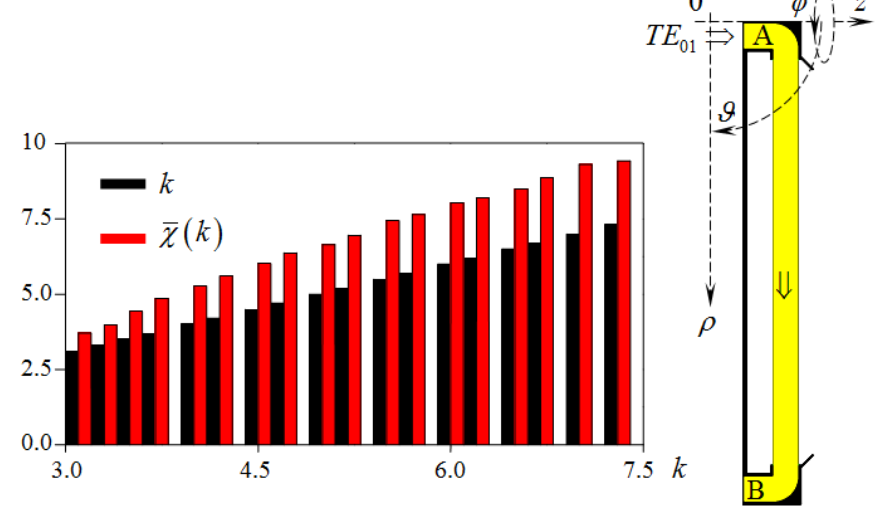
( ) ( k ) of a radial dielectric waveguide. k χ of a radial dielectric waveguide. Figure 3. Surface wave propagation constants χ Figure 3. Surface wave propagation constants The propagation constants χ ( k ) of the radial dielectric waveguide were calculated for the structure (see Figure 3) with following parameters: the radii b ± of the inner conductors of the coaxial waveguides A and B are equal to 0.12 and 15.84, respectively; the radii a ± of their outer conductors are 1.0 and 16.72; and the thickness of the radial dielectric ( ε = 2.1) waveguide is equal to 0.88. The cutoff points of the first three TE 0 n -waves in the ≈ 2.75, k + ≈ 5.14, and k + ≈ 7.55, and in the waveguide B, waveguide A are equal to k + 2 3 1 ≈ 2.46, k − ≈ 4.93, and k − ≈ 7.39. For the analysis, a frequency band 3.1 ≤ k ≤ 7.3, k − 2 3 1 where no more than two TE 0 n -waves can propagate in each of these waveguides without attenuation, was chosen. At the frequency k = 5.2, the average for this range, χ ( k ) = 6.96, γ ( k ) = χ ( k ) / k ≈ 1.34, and the value l satisfying condition (21) is 0.9. Let us load an open dielectric waveguide with a reflective grating with defined above period l = 0.9 and d = h = 0.8 (aiming distance between the waveguide and the grating is c = 0.1) and excite the structure with a pulsed TE 01 -wave, such